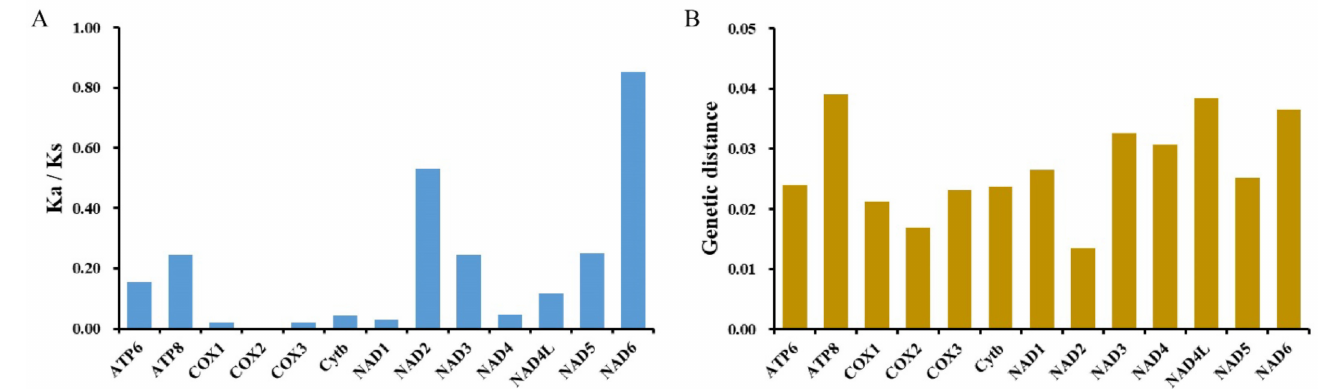
Figure 5. Ka/Ks ( A ) and genetic distance ( B ) analyses of 13 PCGs among four P. sinensis strains . Genetic distance indicates the overall mean distances of 13 PCGs among the four strains using the Kimura 2-parameter model of MEGA X